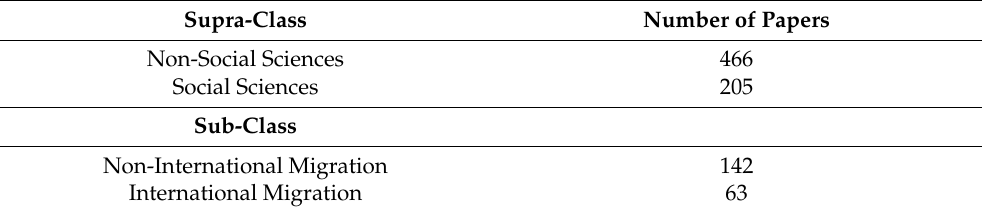
Table 3. Distribution of articles according to their supra and subclasses.